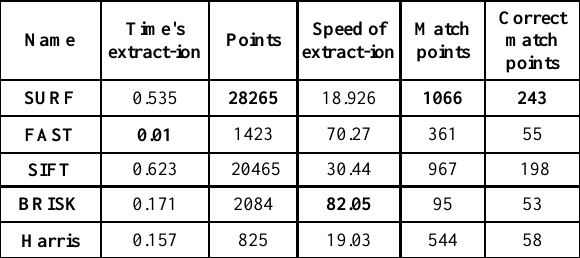
Table 3. Comparison of point extraction algorithms, data set 3